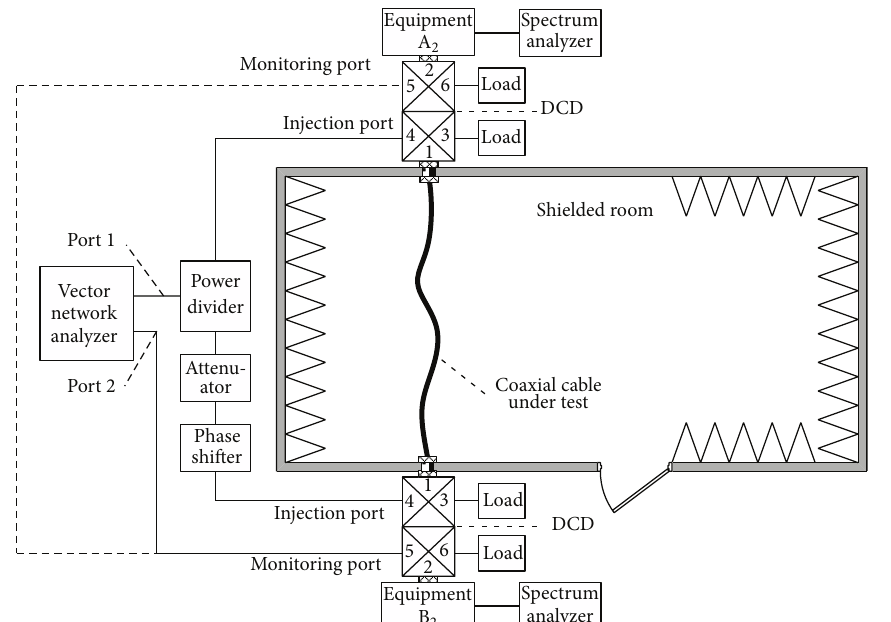
Figure 17: The configuration diagram for the DDMCI test.